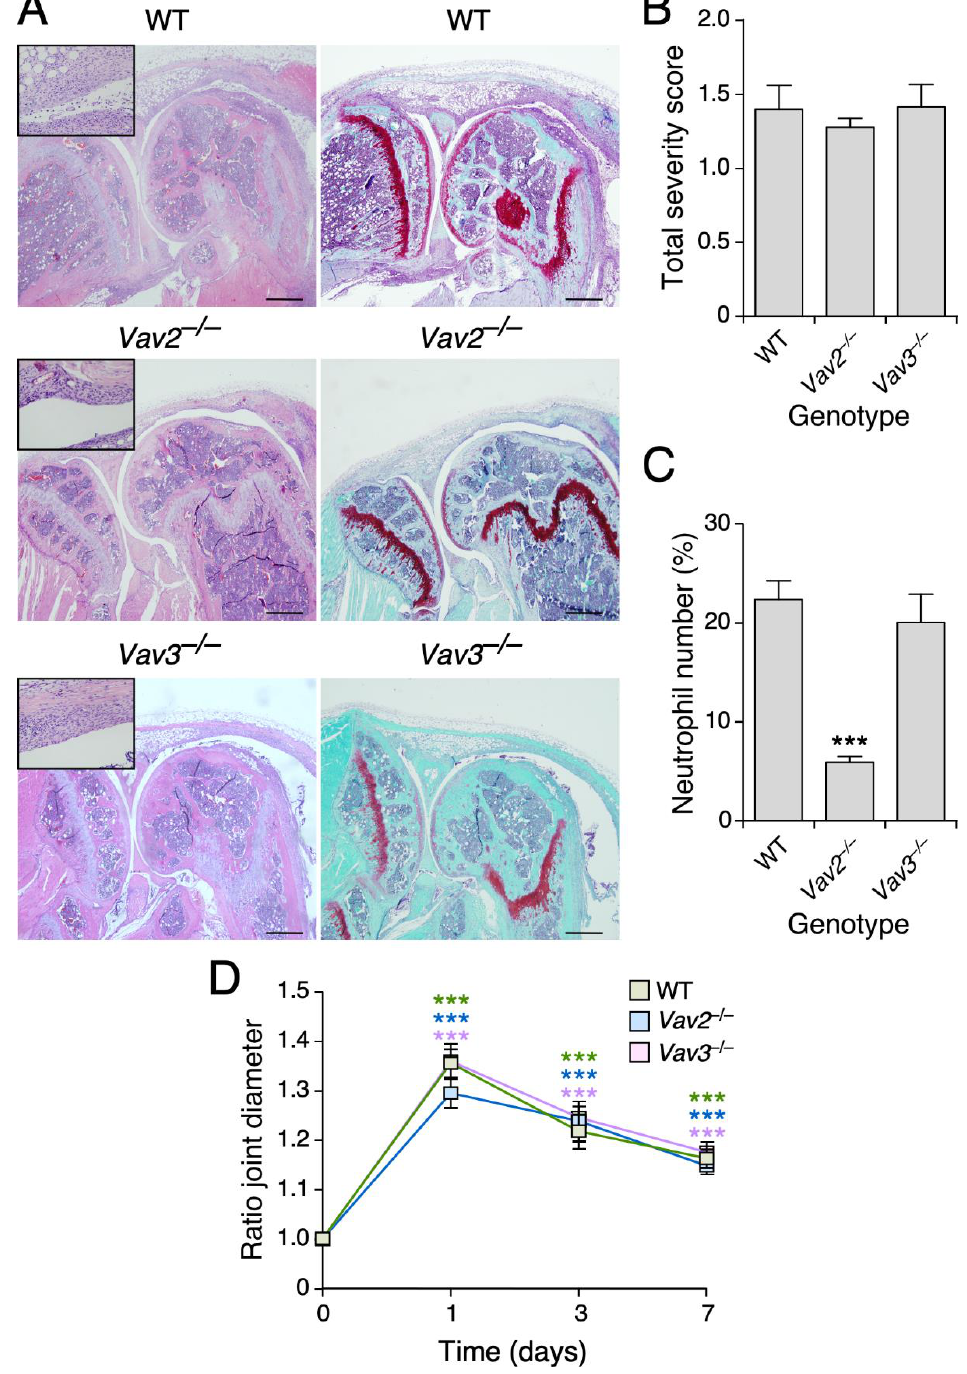
Figure 5. Vav2 is the family member required for sustained inflammatory responses in Zymosan A-treated joints. ( A ) Representative images of histological sections of arthritic knee joints of mice of the indicated genotypes stained with either